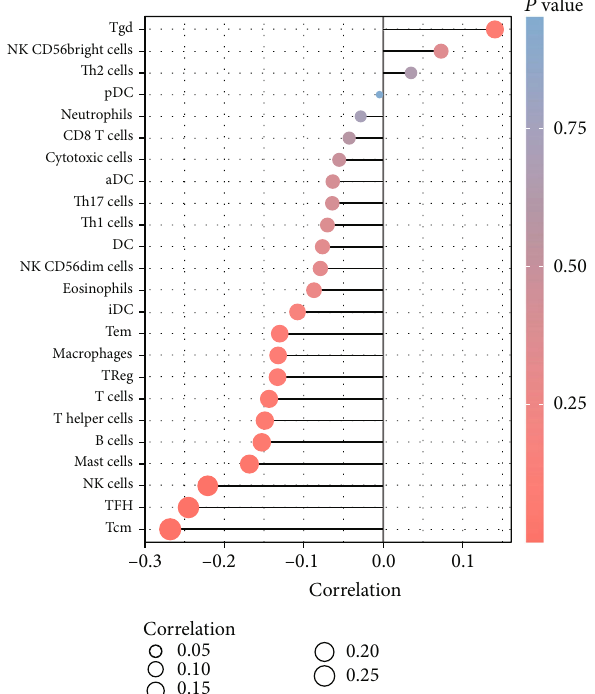
Figure 9: Associations of the COX7B expression level with tumor immune in fi ltration in ESCA. COX7B expression was inversely related to TFH, Tcm, NK cells, and mast